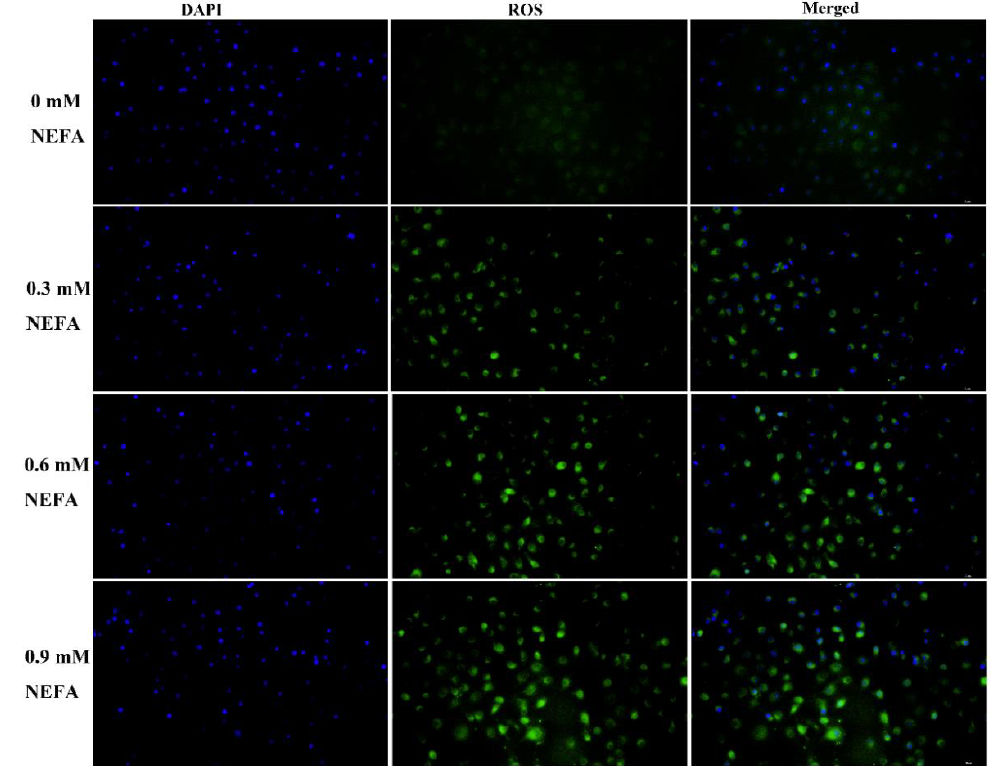
Figure 5. Accumulation of ROS in BMECs after NEFA treatment. Intracellular ROS levels in BMECs treated with different concentrations of NEFA (0, 0.3, 0.6, 0.9 mM) were observed by immunofluorescence (green); DAPI was used for nuclear staining (blue).